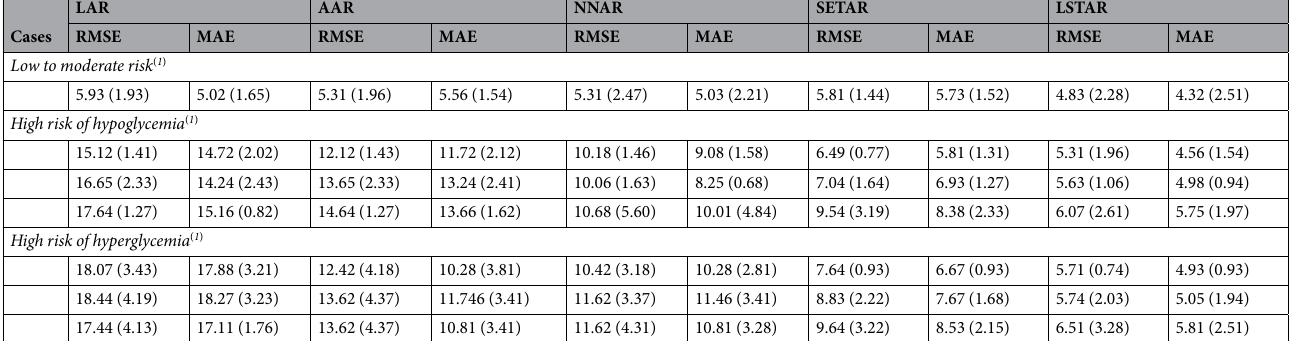
Table 3. Average prediction accuracy of AR models for PH of 30-minutes (RMSE – Root Mean Squared Error ; MAE – Mean Absolute Error ). (1) Values are presented as mean (standard deviation).